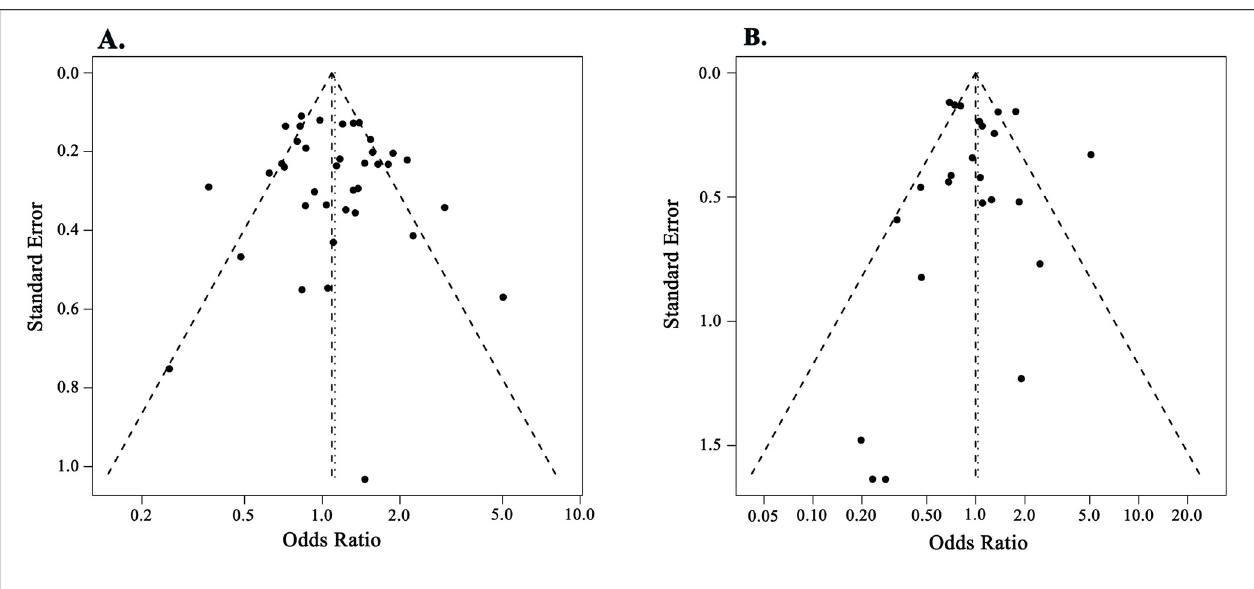
Fig 4. Funnel plot for publication bias checking of HIF1A variants (a) 1772 C/T for C allele vs. T allele (b) 1790 G/A for A allele vs. G allele.